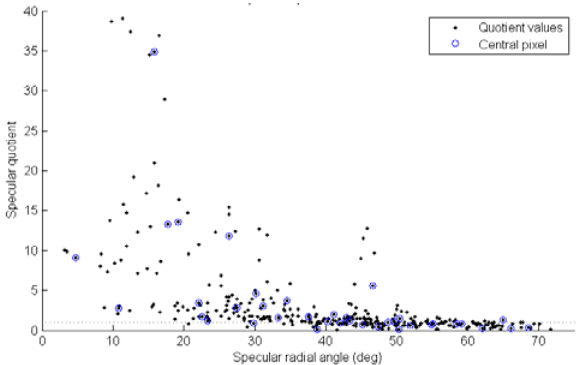
Figure 15. Specular quotient distribution in a region 3x3 pixels.